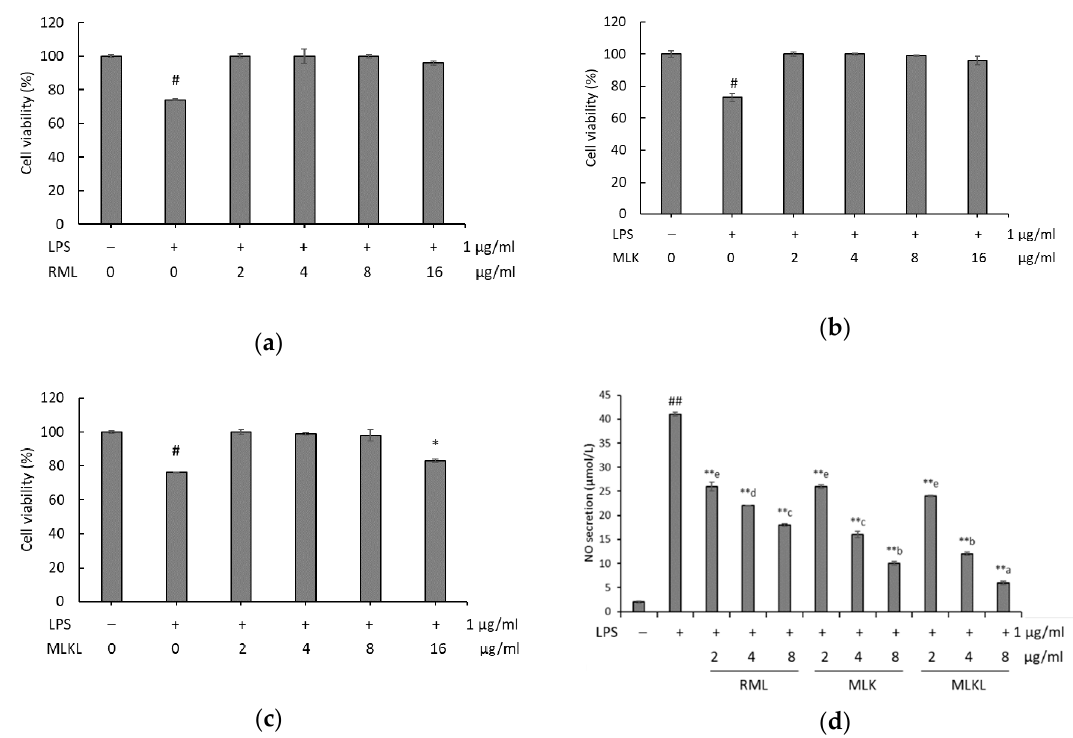
Figure 2. Effect of ( a ) raw mustard leaves (MLK); ( b ) mustard leaf kimchi (MLK); ( c ) mustard leaf kimchi fermented by L. plantarum (MLKL) on protective effect and ( d ) NO production in lipopolysaccharides (LPS)-induced RAW264.7 cells. Data were presented as the mean ± standard deviation (SD) of three independent experiments. Means sharing the same alphabet in superscript within each sample are not significantly different at p < 0.05 by ANOVA and Duncan’s multiple range test. * p < 0.05, ** p < 0.01 vs. LPS, and # p < 0.05, ## p < 0.01 vs. the LPS-stimulated group.